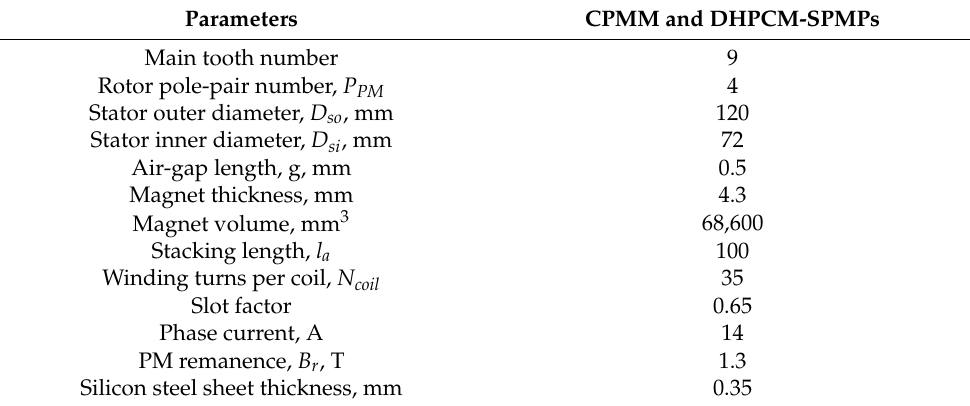
Table 1. Structure parameters of the two motors.